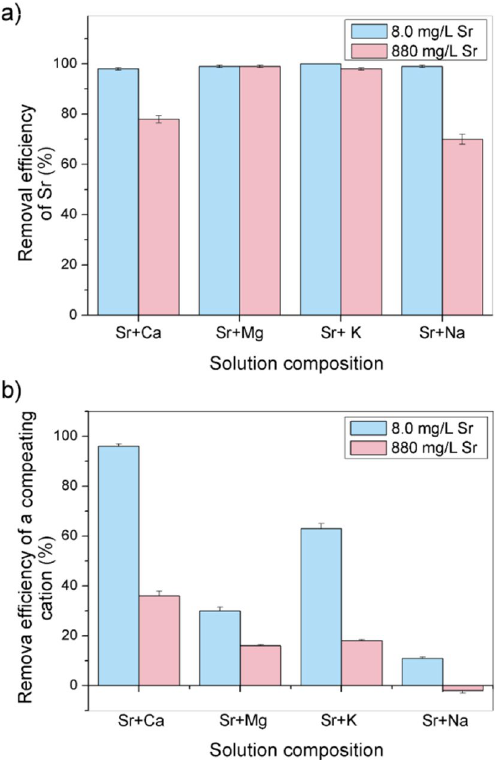
Figure 7. Removal efficiency of Sr ( a ) and the competing cation ( b ) from bi-component solutions having initial Sr concentrations of either 8.0 mg/L or 880 mg/L and competing cation concentration typical for SW (420 mg/L Ca, 1200 mg/L Mg, 320 mg/L K, and 10,600 mg/L